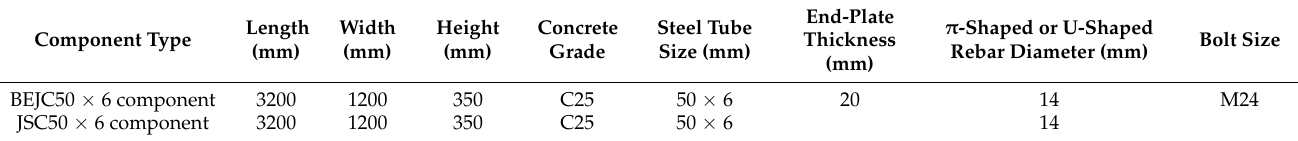
Table 1. Main structural parameters of the tested components.